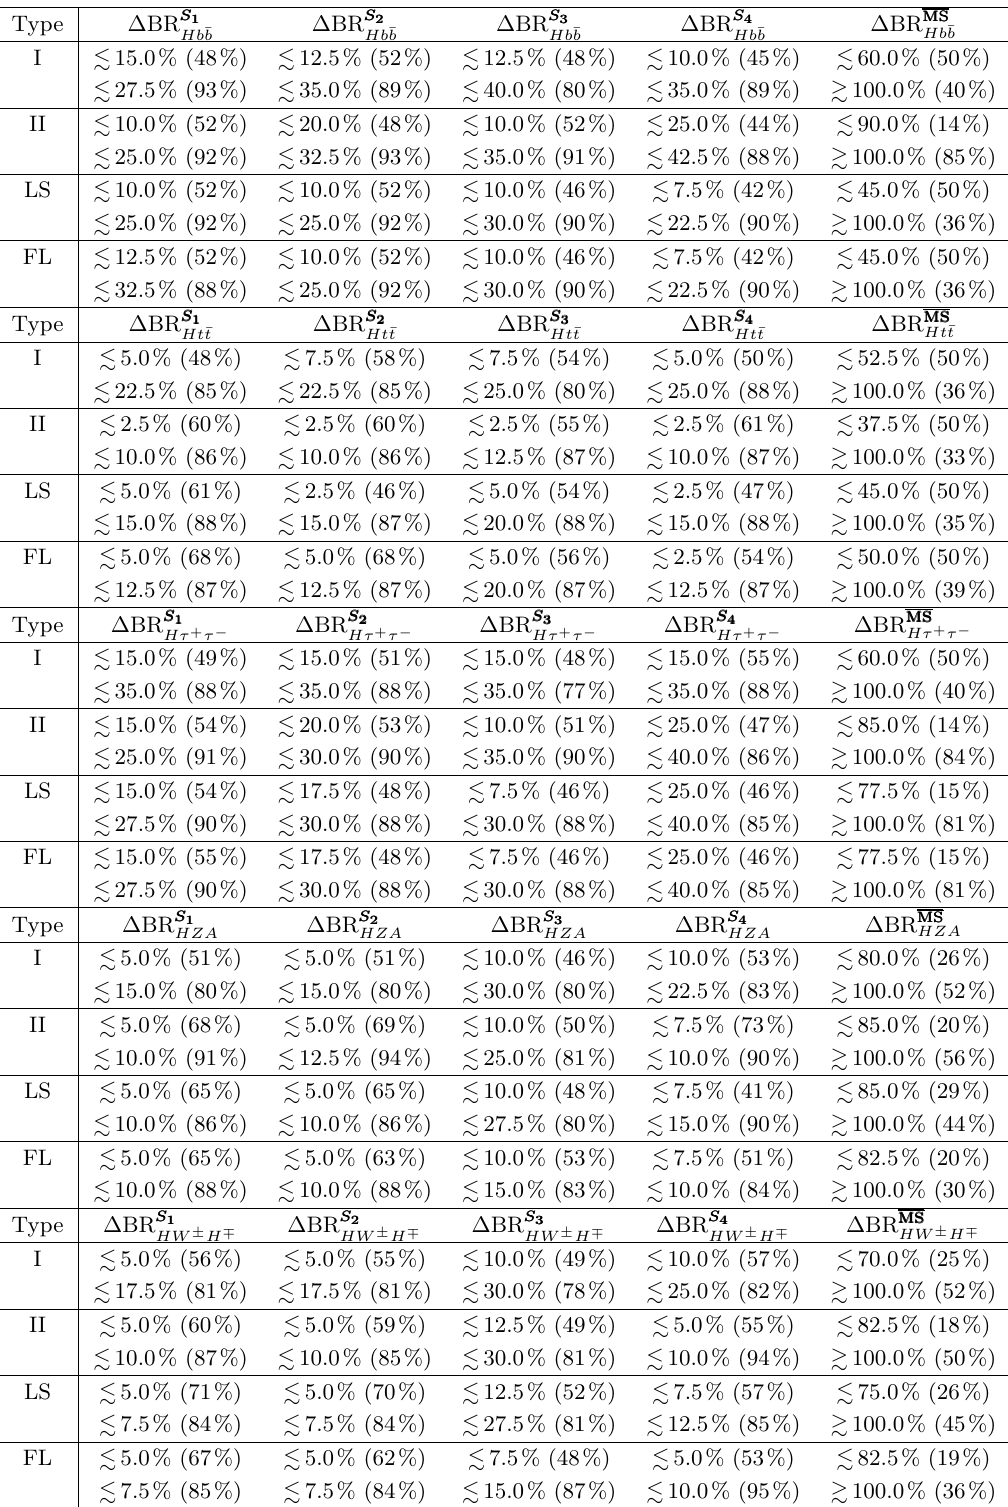
Table 9 . Relative size of the EW corrections to the BRs for the non-SM-like 2HDM Higgs